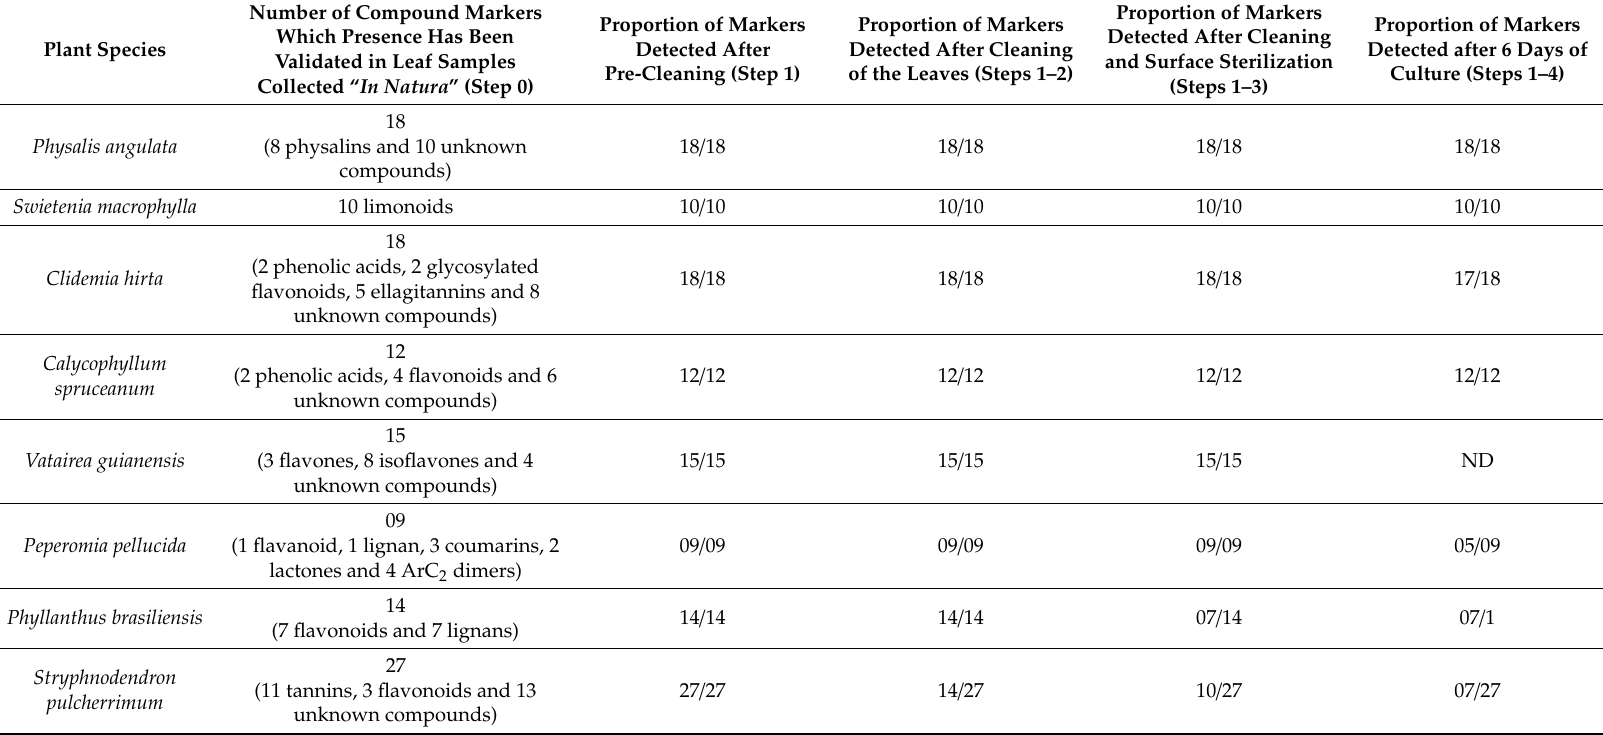
Table 2. Survey of some selected compound markers presence during the di ff erent steps of in vitro cultures